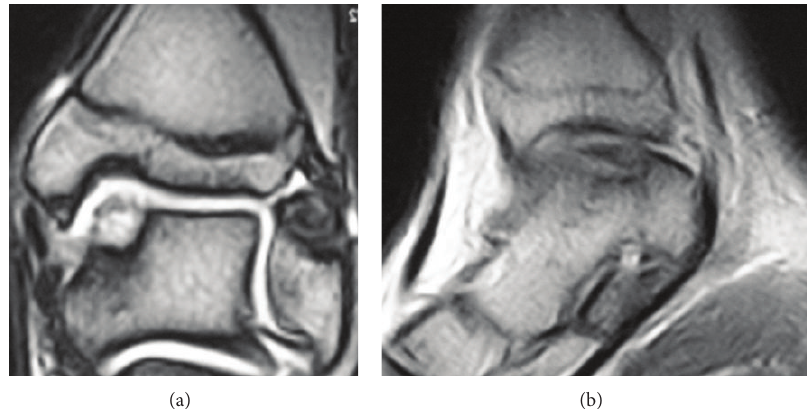
Figure 1: Preoperative coronal (a) and sagittal (b) MRI views before the first operation, showing a IIA type lesion, according to Giannini’s